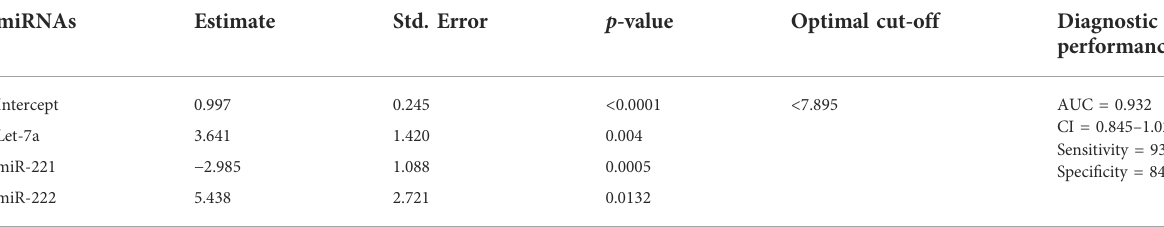
TABLE 3 Stepwise logistic regression analysis of candidate miRNAs. The statistical analysis was done using GraphPad Prism 5.0.